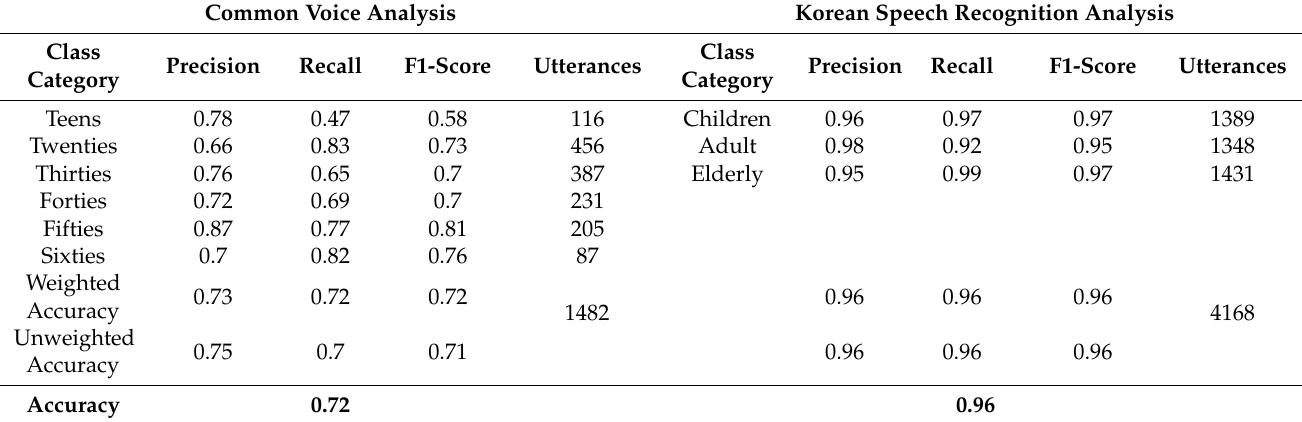
Table 7. Classification of the proposed age classification model on each dataset presents the precision, recall, F1-score, and weighted and unweighted accuracy results. Numbers with bold fonts indicate the average classification